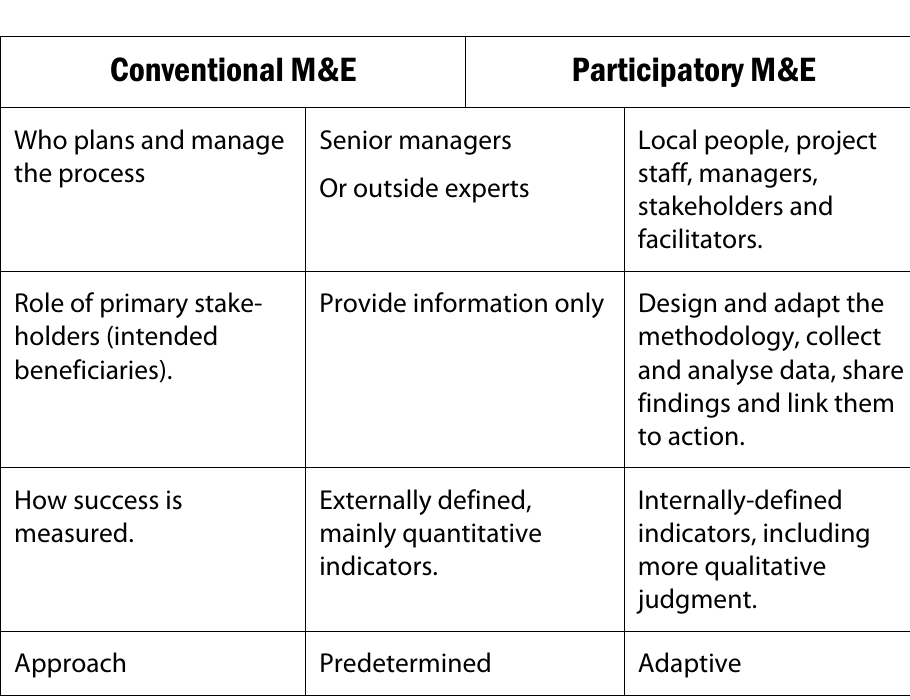
Table 1: difference between conventional monitoring and evaluation and the Participatory Monitoring and Evaluation (Source: The World Bank.